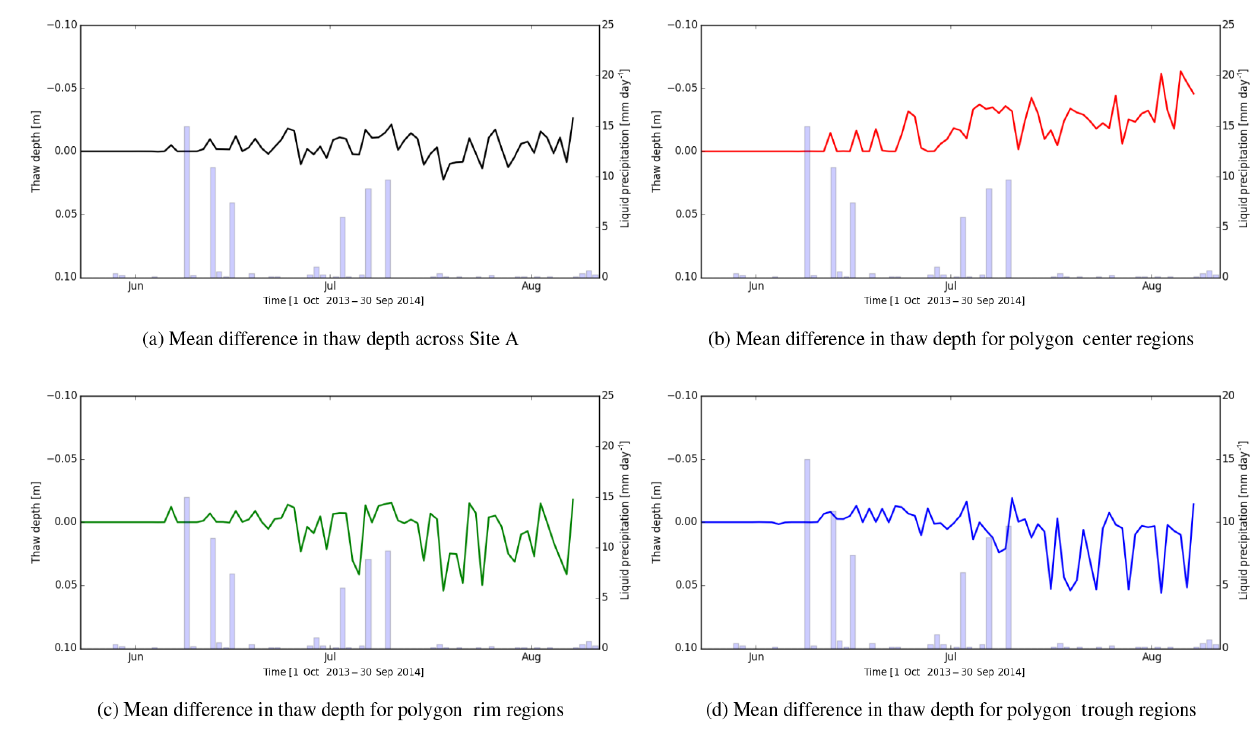
Figure E7. Mean difference in thaw depth between 1-D models compared to 3-D models. A positive bias indicates higher thaw depth in 1-D simulations compared to 3-D models, while negative values indicate lower thaw depths. Daily precipitation patterns (in millimeters per day) are shown by blue